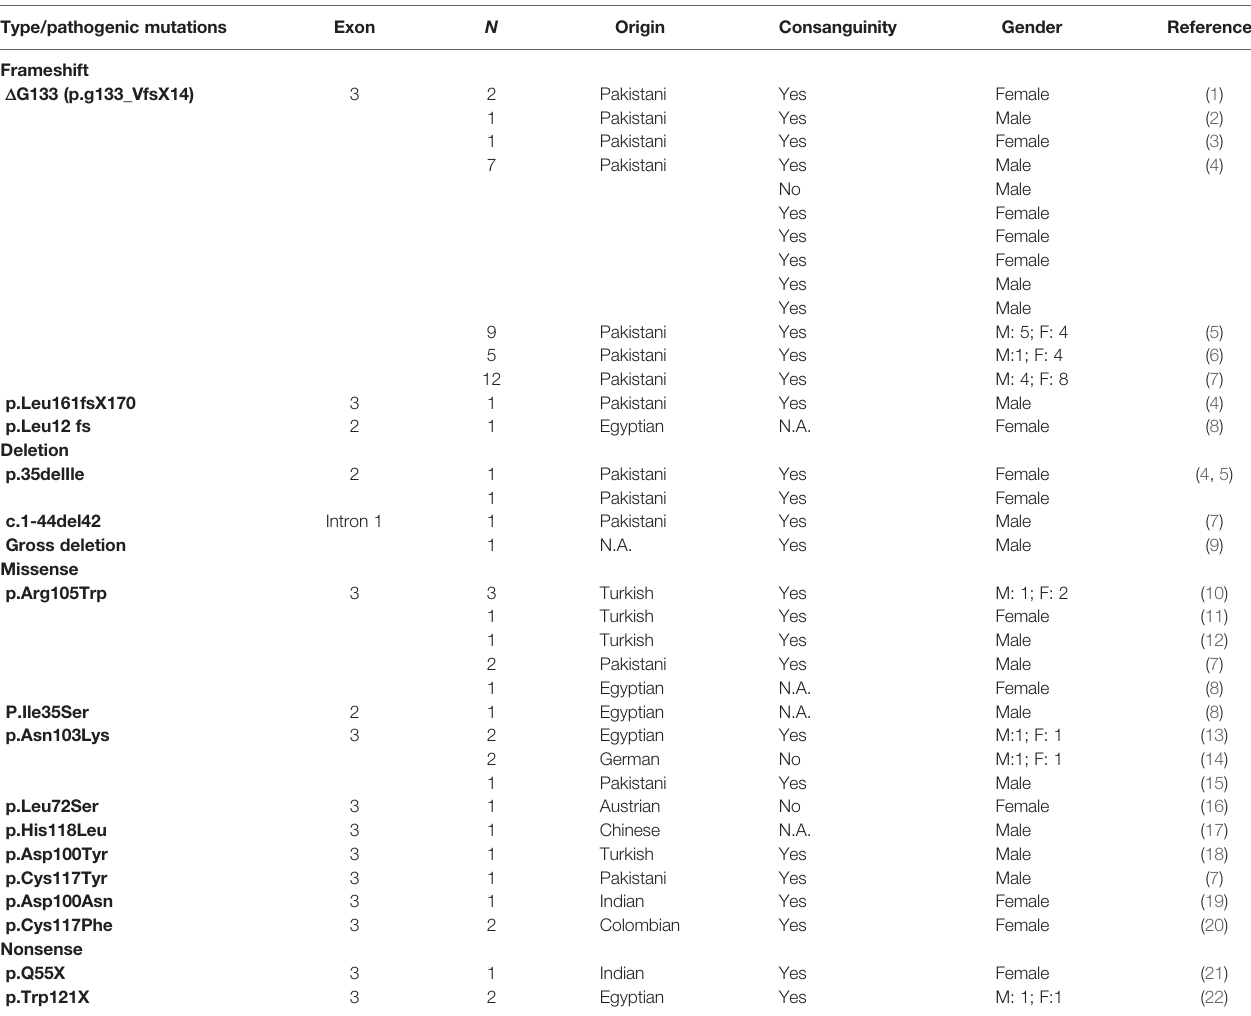
TABLE 2 | Monogenic variants identi fi ed in leptin gene. Type/pathogenic